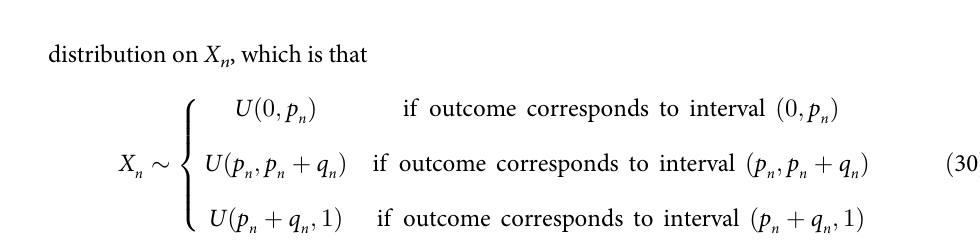
Fig 8. Predicting goals scored by each team. The number of goals scored by each team, alongside the predicted (mean) number of goals scored and an approximate 95% prediction interval.